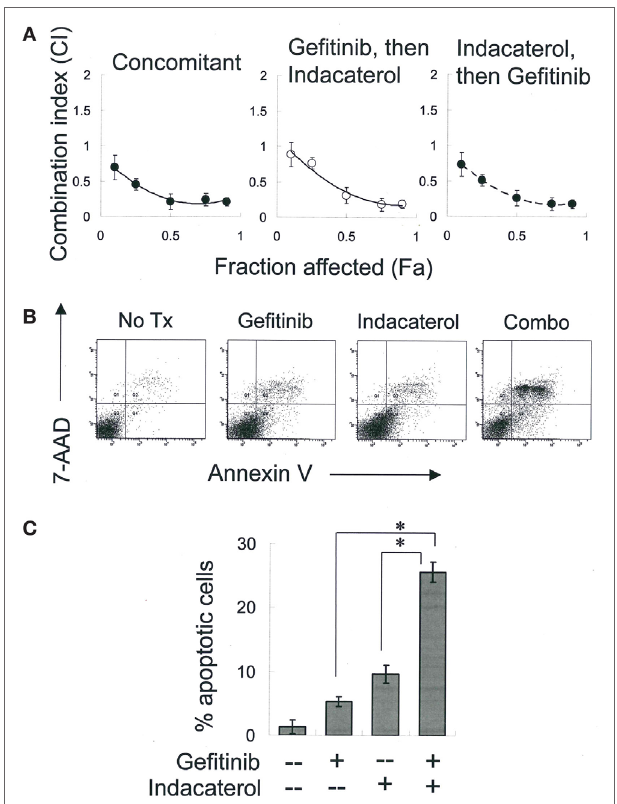
FigUre 4 | Combination of gefitinib and indacaterol giving rise to synergistic anticancer activity. (a) Combination index (CI) plot showing anticancer activity of combination of gefitinib and indacaterol in different sequence. CI values were plotted as a function of fractional growth inhibition (Fa). CI < 1, = 1, and > 1 suggest synergism, additivity, and antagonism, respectively. (b) Indacaterol sensitized H1975 cells to gefitinib-mediated apoptosis. Cells were treated with gefitinib alone (4 µM), indacaterol alone (5 µM), or their concomitant combination for 48 h before harvest for apoptosis assay. A representative set of data from three independent experiments is shown. (c) Summary of apoptosis assay data in (b) . Data are presented in histogram as mean ± SD. * p < 0.05, Student’s t